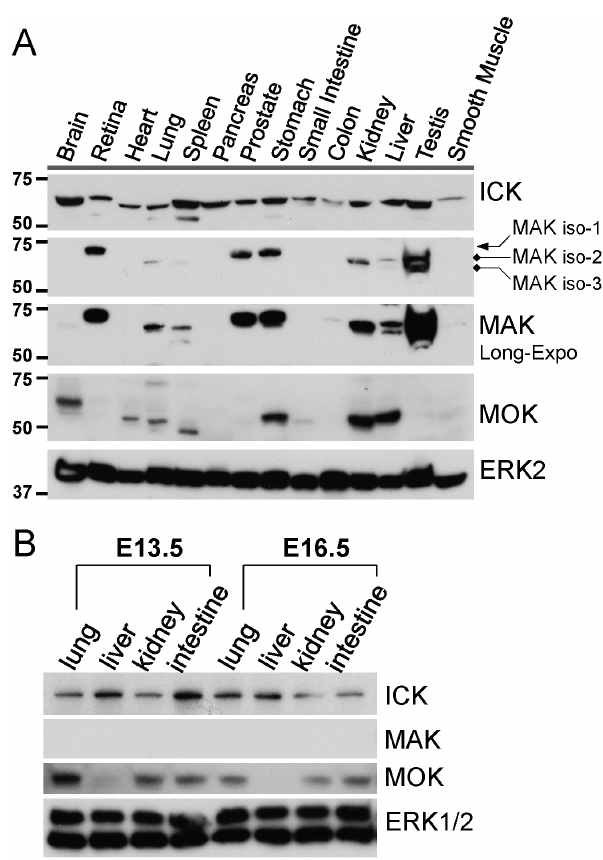
Figure 2. Expression of ICK/MAK/MOK proteins in young adult and embryonic mouse tissues. (A) Equal amount of total proteins (50 m g) extracted from various frozen tissues of young adult C57BL/6J mice (8 week-old) were Western blotted against antibodies recognizing ICK, MAK, and MOK respectively. Western blot signal of ERK2, closely related to ICK/MAK/MOK, was also shown as a control to indicate a universal expression pattern in various young adult mouse tissues. (B) Equal amount of total proteins (50 m g) extracted from frozen tissues (lung, liver, kidney and intestine) of mouse embryos of E13.5 and E16.5 were Western blotted against antibodies recognizing ICK, MAK, and MOK respectively. Western blot signals of ERK1/2 were shown as controls to indicate a universal expression pattern in various mouse